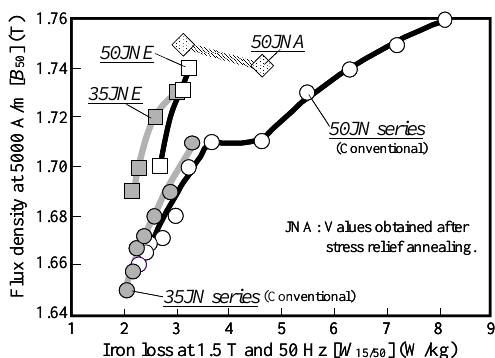
Figure 1. Map of magnetic properties of electrical steel products by iron loss W 15/50 and material flux density B 50 .